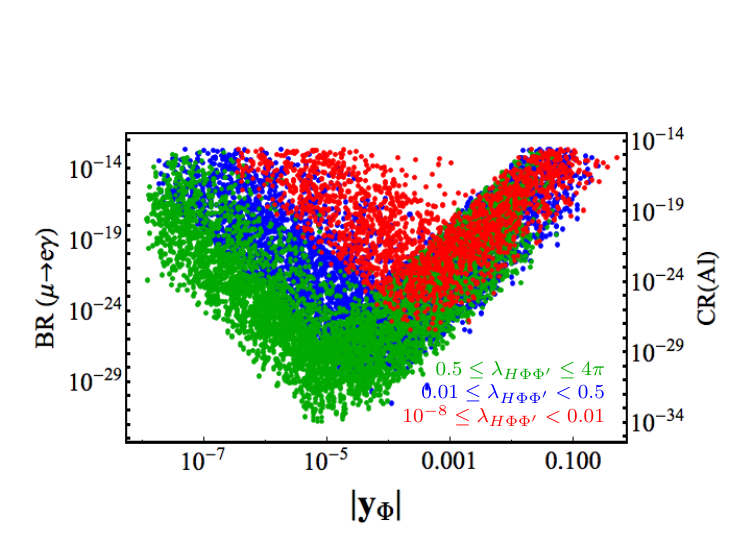
e(cid:13) (left axis) and the (cid:22) !